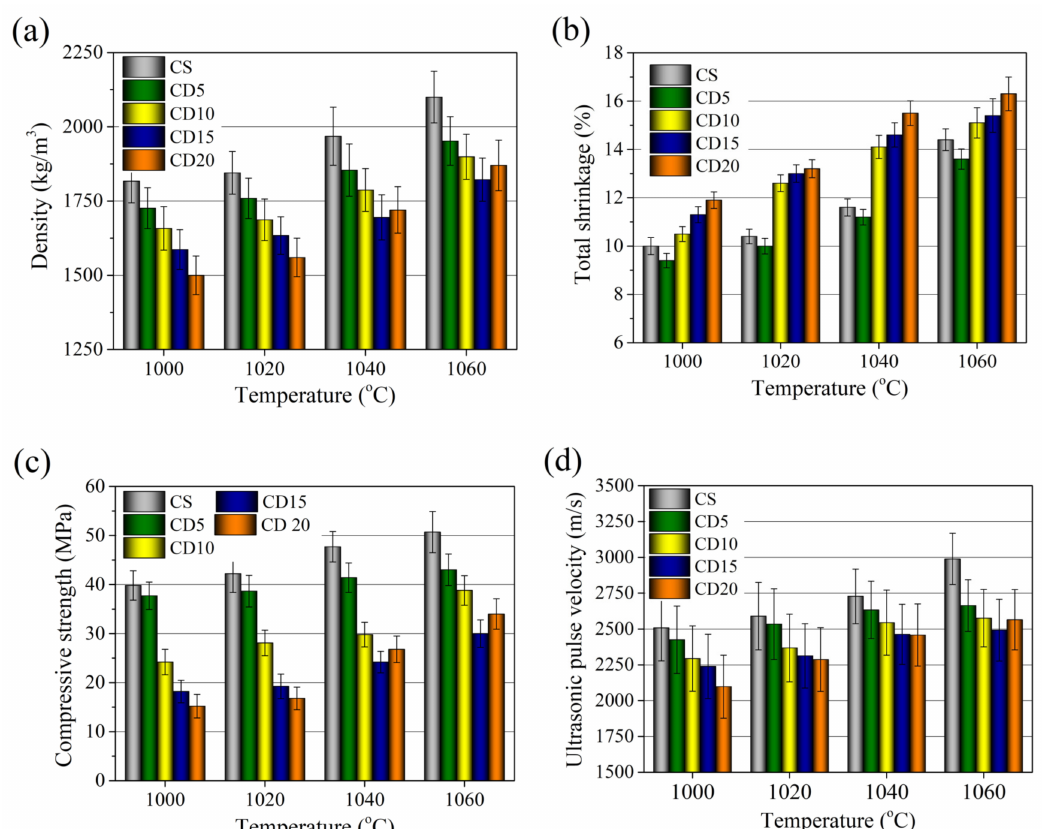
Figure 13. Physical and mechanical properties of the ceramic bodies fired at 1000–1060 ◦ C: ( a ) density, ( b ) total shrinkage, ( c ) compressive strength, ( d ) ultrasonic pulse